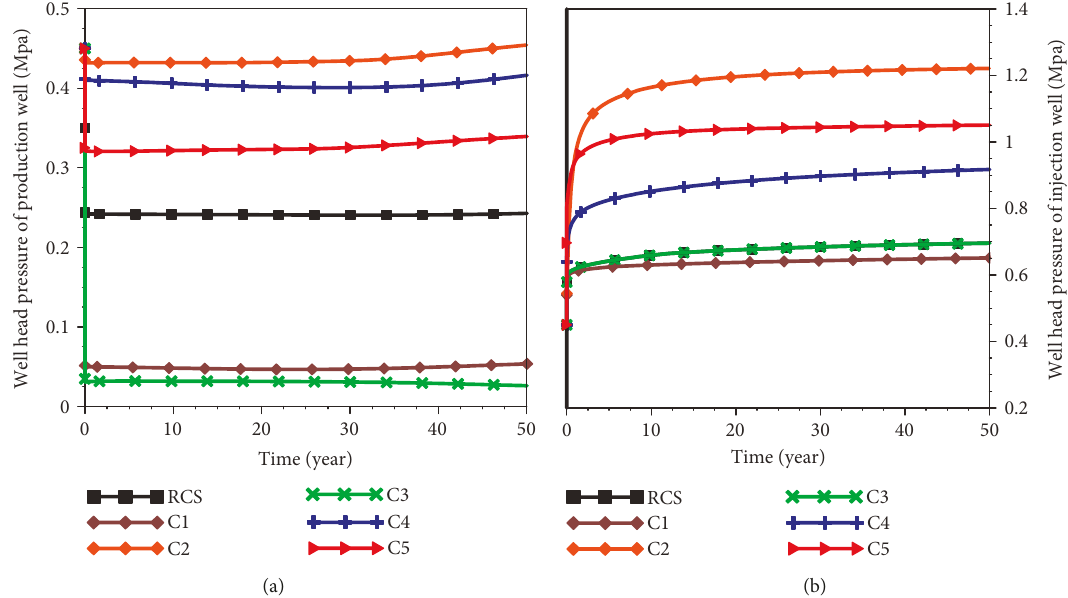
Figure 11: Wellhead pressure of production well (a) and injection well (b) over time by contrasting the RCS and fi ve heterogeneous cases (C1, C2, C3, C4, and